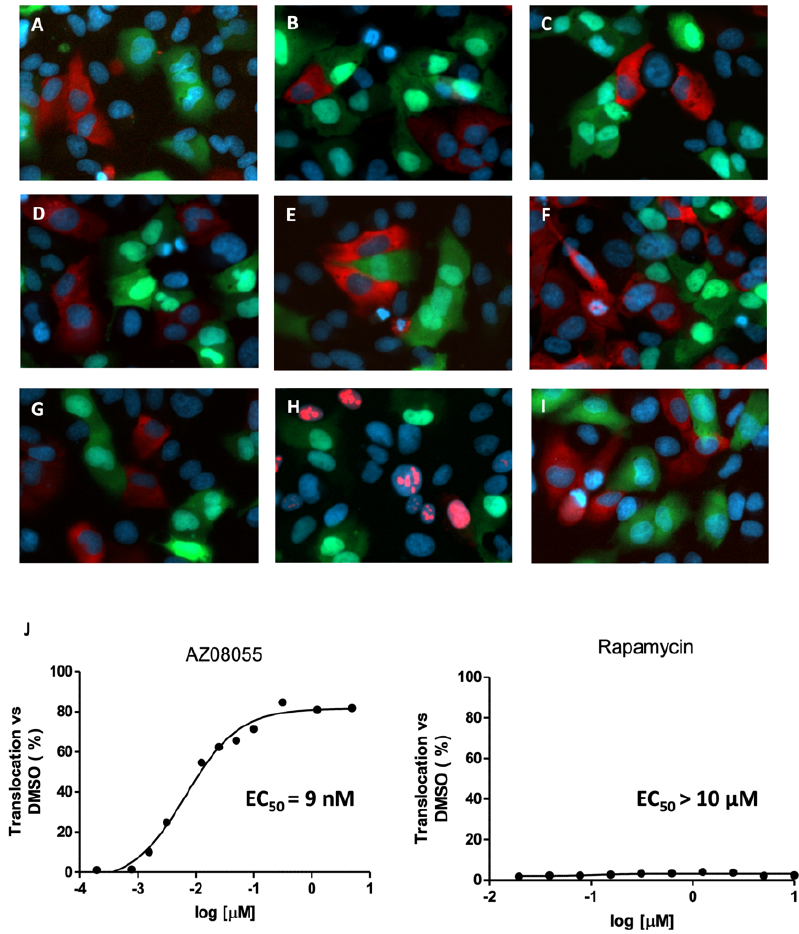
Figure 3. Effect of mTORC inhibitors on nuclear translocation of FOXO3. mTORC1 inhibition does not affect FOXO3 accumulation. Multiplexed assay with U2foxRELOC and U2redNES cells co-cultured and treated with ( A ) 0.5% DMSO or 500 nM, ( B ) dactolisib, ( C ) PI103, ( D ) torin, ( E ) KU-0063794, ( F ) sapanisertib, ( G ) AZD8055, ( H ) rapamycin, ( I ) 20 nM LMB for 1 h. Then cells were fixed and nuclear stained with Hoechst. Representative images are shown at 40 × magnification. ( J ) Dose-response plotting of AZD8055 and rapamycin with EC 50 of 9 nM and >10 µ M,